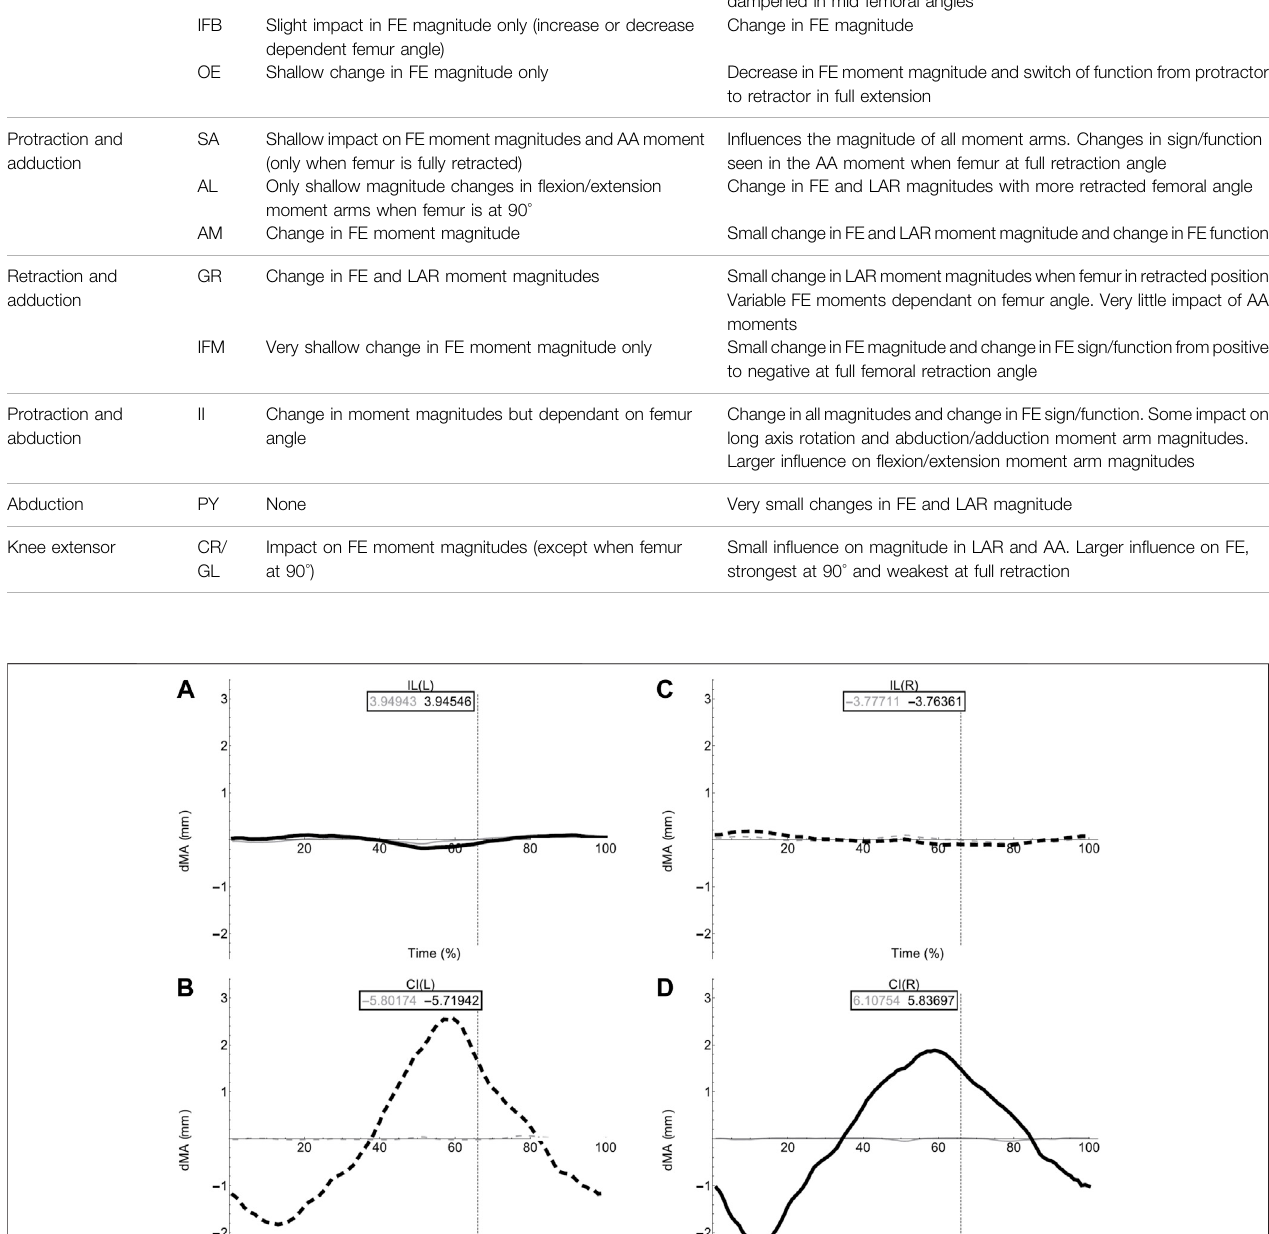
Frontiers in Bioengineering and Biotechnology |